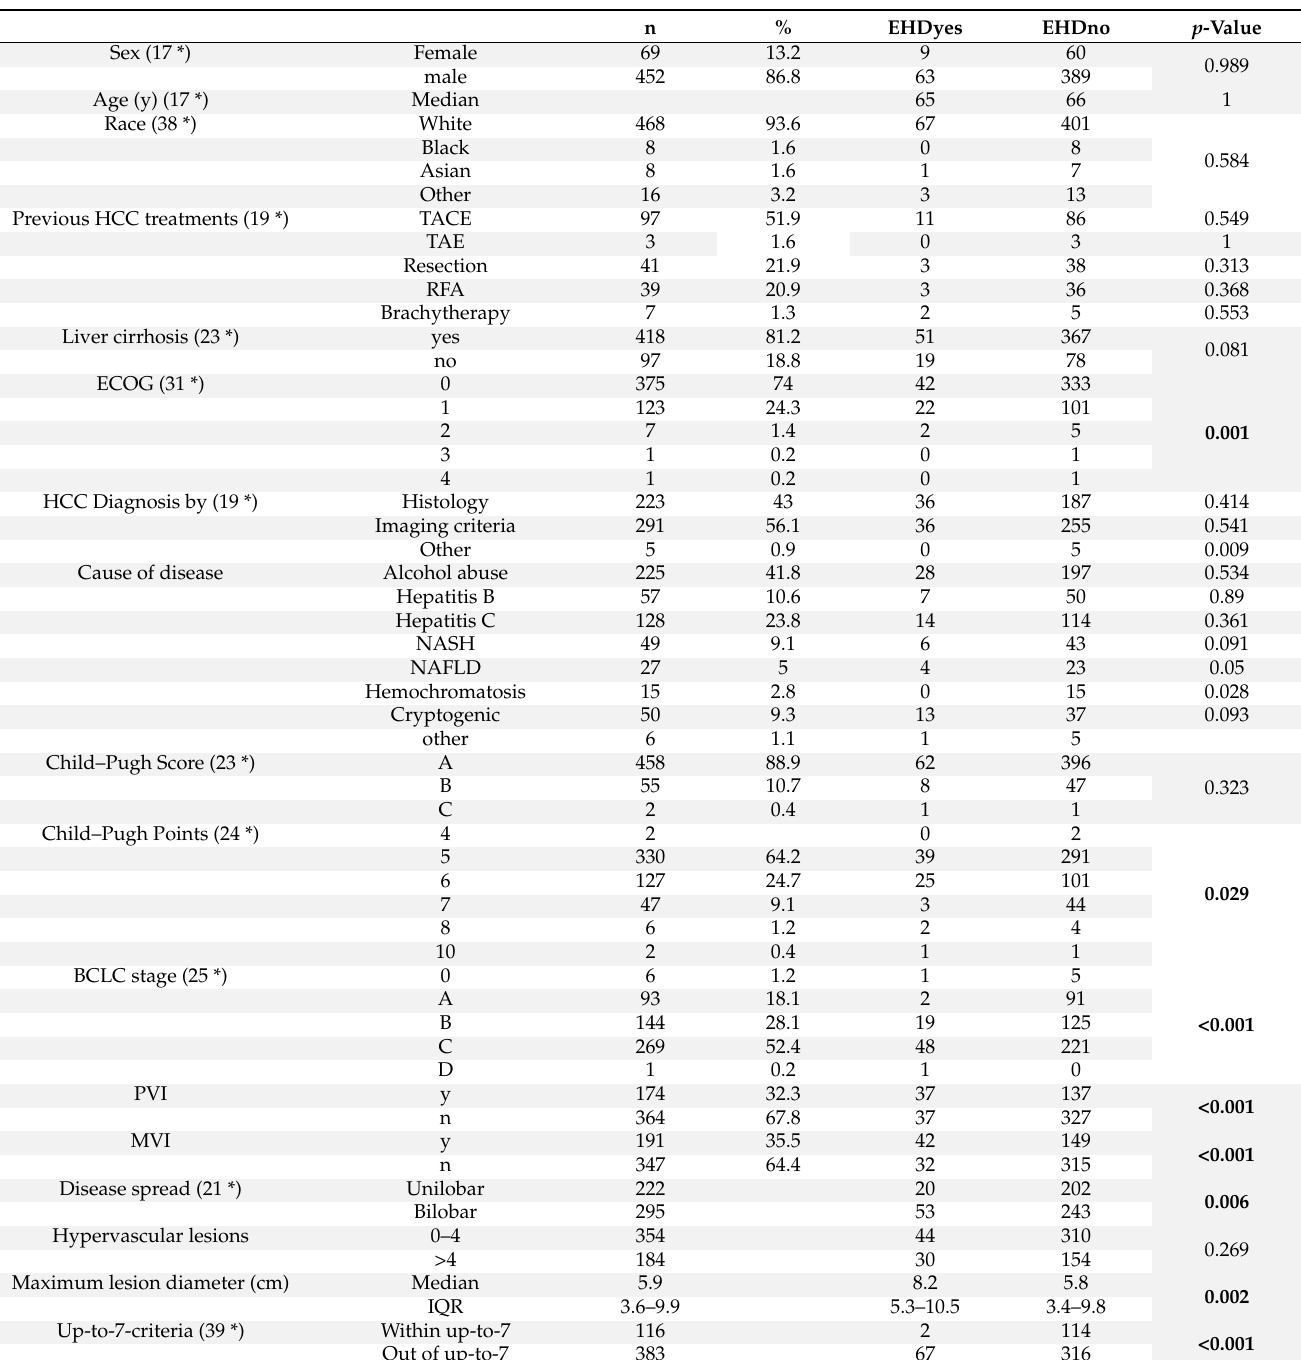
Table 1. Baseline characteristics of all 538 included patients from the SORAMIC trial. The presence of EHD (EHDyes/EHDno) and respective p -values are displayed according to the decision of the truth